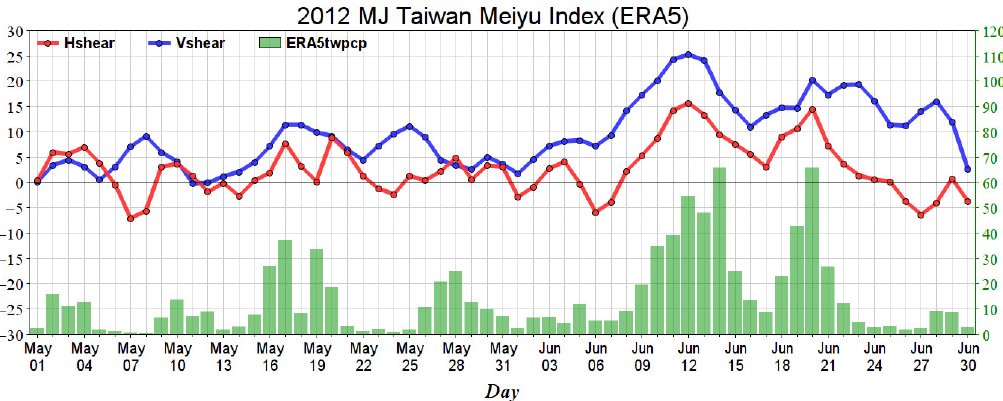
Figure 8. Same as Figure 7, but the time-series of Meiyu index and precipitation in